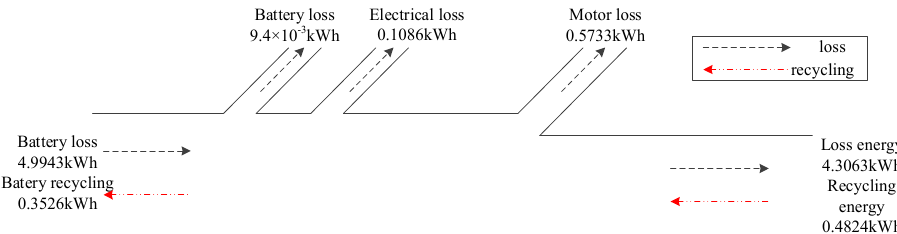
Figure 16. HESS power when using fuzzy control.